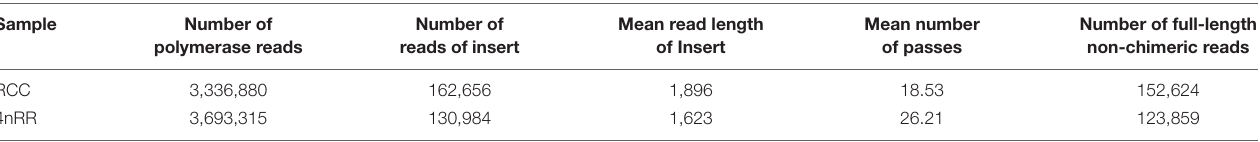
FIGURE 2 | The morphological appearances, chromosome metaphase spreads, and examination of FISH signals in RCC, and 4nRR. (A) Carassius auratus red var. (RCC). (B) Autotetraploid Carassius auratus (4nRR). The bar in (A,B) is representative of 1 cm. (C) The 100 chromosome of RCC. (D) The 200 chromosome of 4nRR. (E) There were eight 5S gene loci in RCC (indicated by white arrows). (F) There were sixteen 5S gene loci in 4nRR (indicated by white arrows). The bar in (C–F) is representative of 3 µ m. TABLE 4 | Summary of reads of